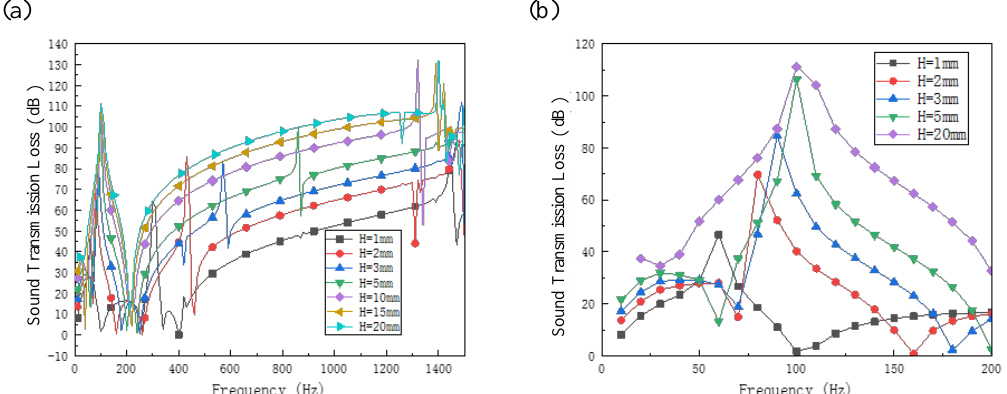
Figure 15. E ff ect of plate thickness on STL for cavity thickness of 20 mm: ( a ) 0–1500 Hz and ( b ) 0–200 Hz.